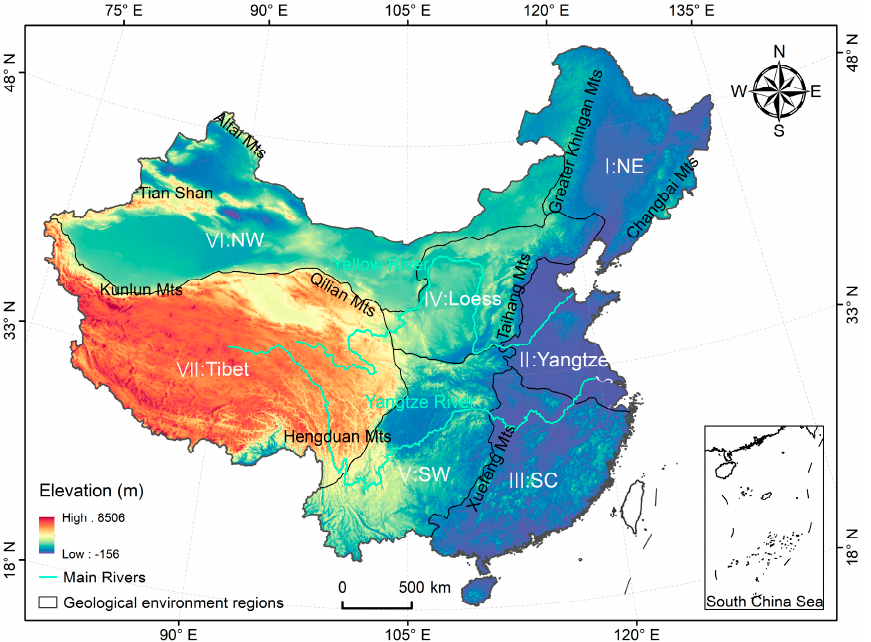
Figure 1. Overview map of China. The seven geological environment regions are shown as the Northeastern plain and mountain region (I: NE); the Huang–Huai–Hai–Yangtze River Delta plain region (II:Yangtze); the South China low mountain and hill region (III:SC); the North China Loess Plateau region (IV:Loess); the Southwest karst mountain region (V:SW); the Northwest mountain and basin region (VI:NW); and the Qinhai–Tibet Plateau region (VII:Tibet).